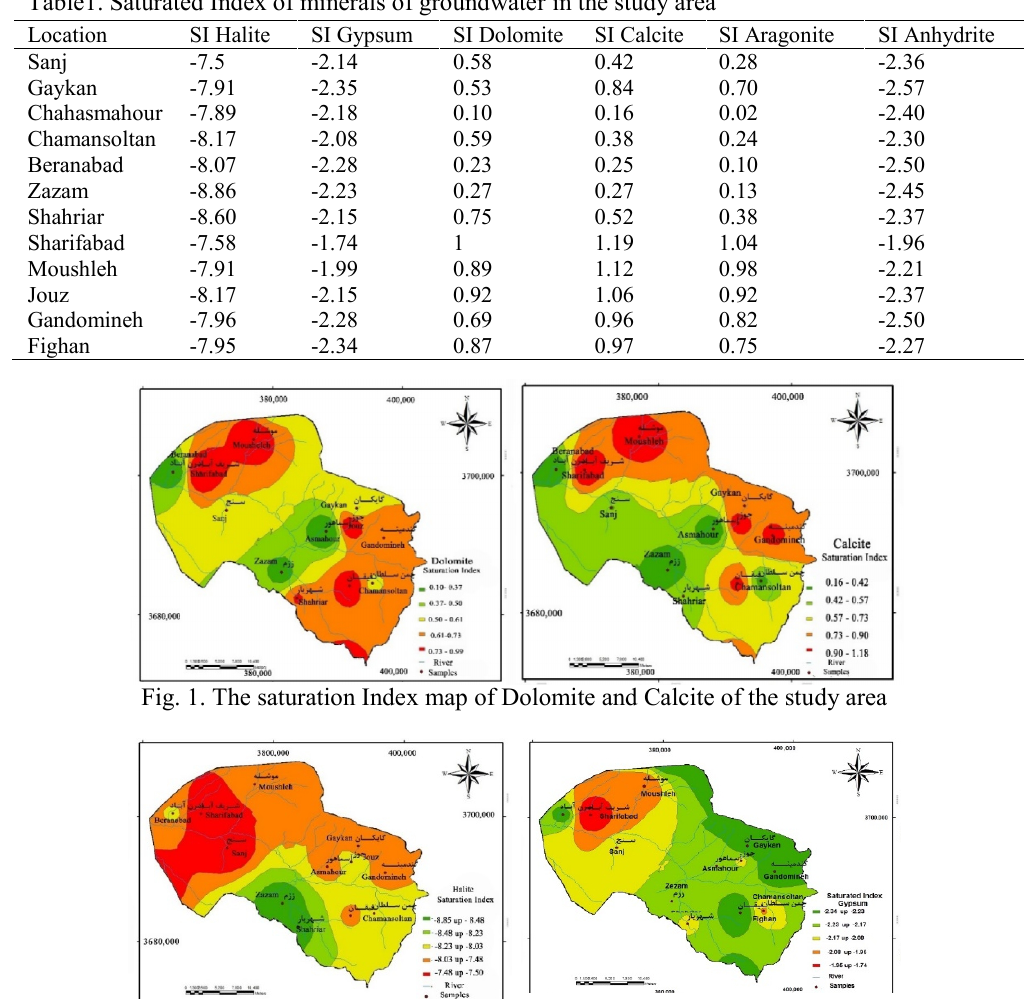
Fig. 2. The saturation Index map of Gypsum and Halite of the study